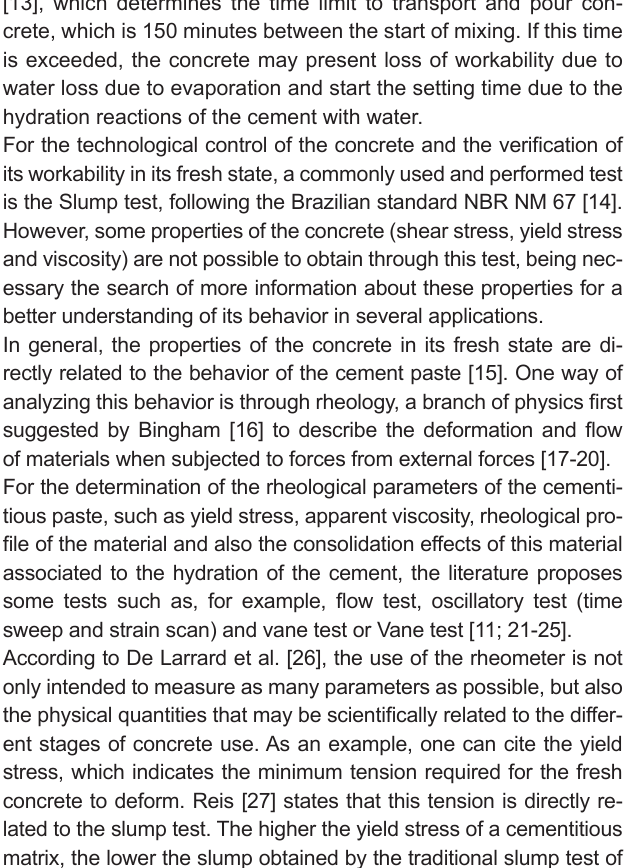
Setting time Resistance to compression